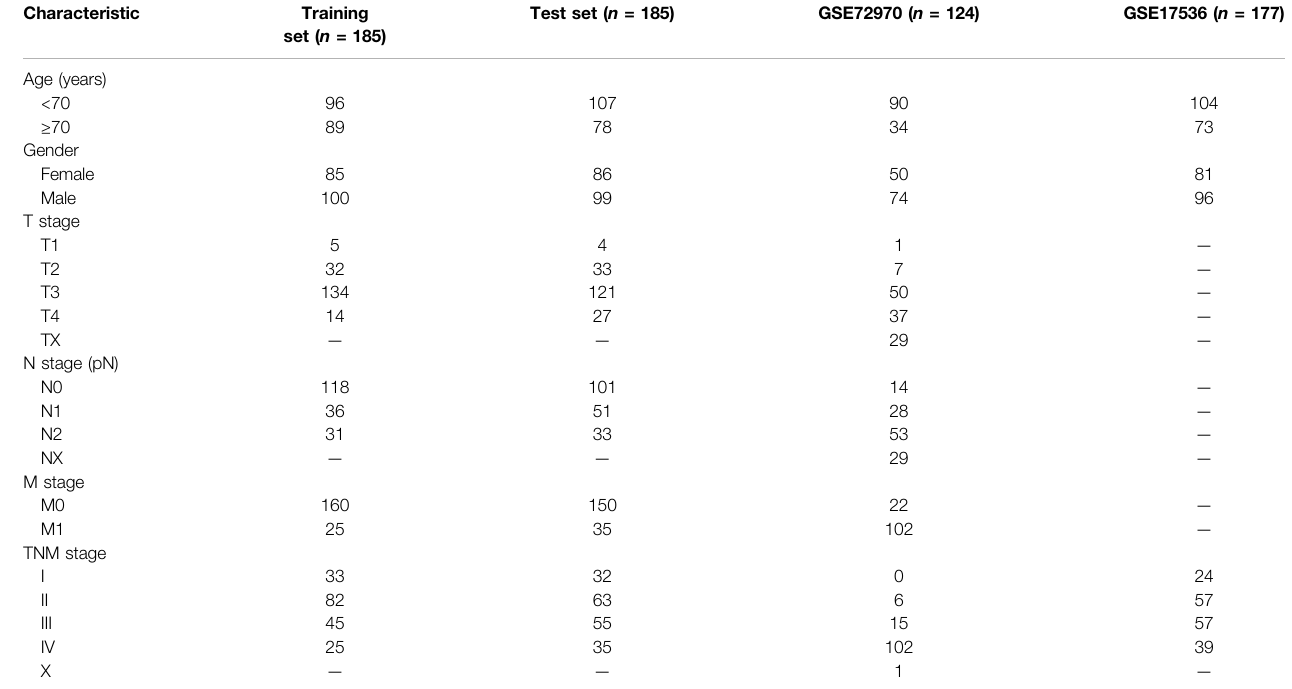
TABLE 1 | Characteristics of CC patients in our